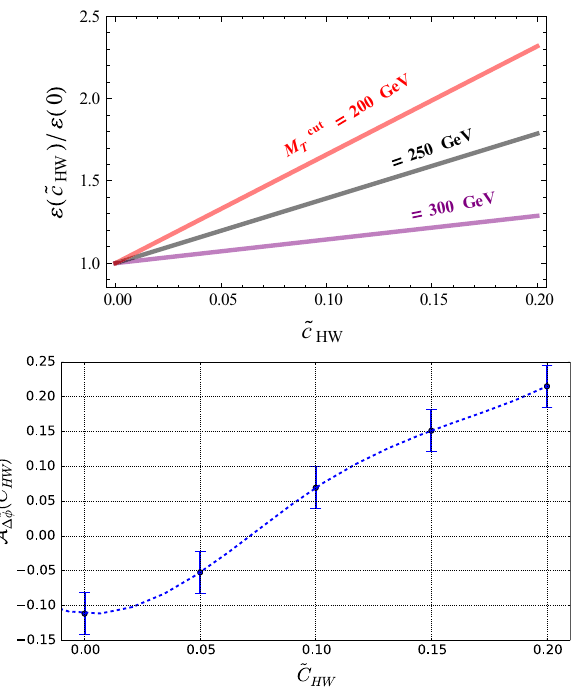
Fig. 8 Same as in Fig. 6 but for W H production